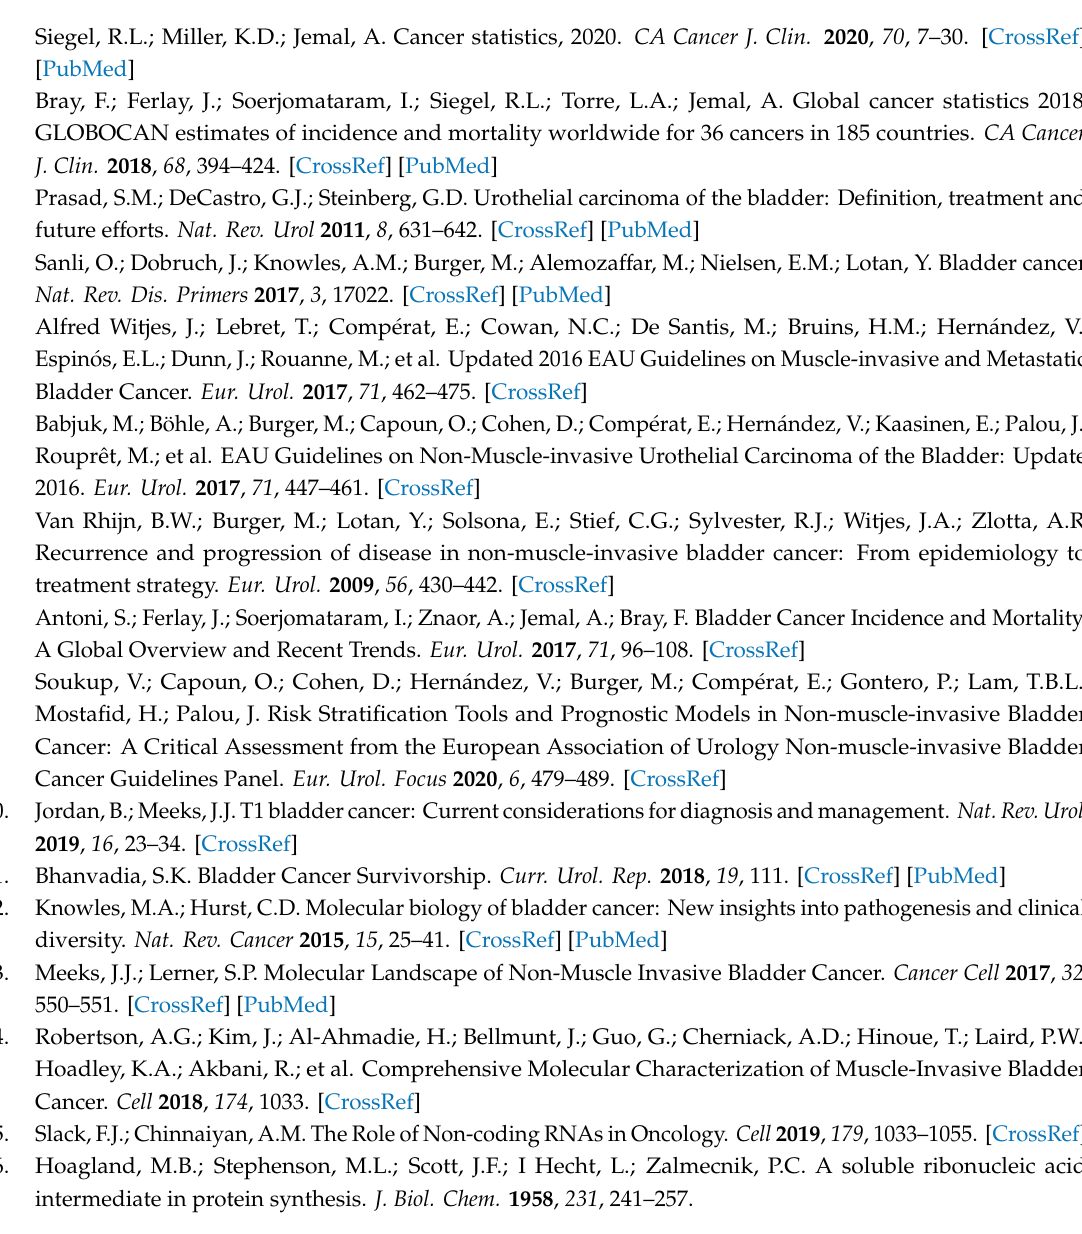
of 5 (cid:48) -tRF-LysCTT for the (a) 2-years progression-free survival and (b) 2-years disease-free survival of NMIBC (TaT1) patients, as well as the (c) 1-year overall survival and (d) 1-year disease-free survival of the MIBC (T2-T4) patients of our screening cohort, Table S1: Cox regression analysis for the prediction of NMIBC (TaT1) patients’ risk for relapse (DFS) and progression to invasive tumors (PFS) following TURBT according to 5 (cid:48) tRF-LysCTT levels. Table S2: Cox regression analysis for the prediction of MIBC (T2-T4) patients’ risk for relapse (DFS) and overall survival (OS) following RC according to 5 (cid:48) tRF-Lys-CTT